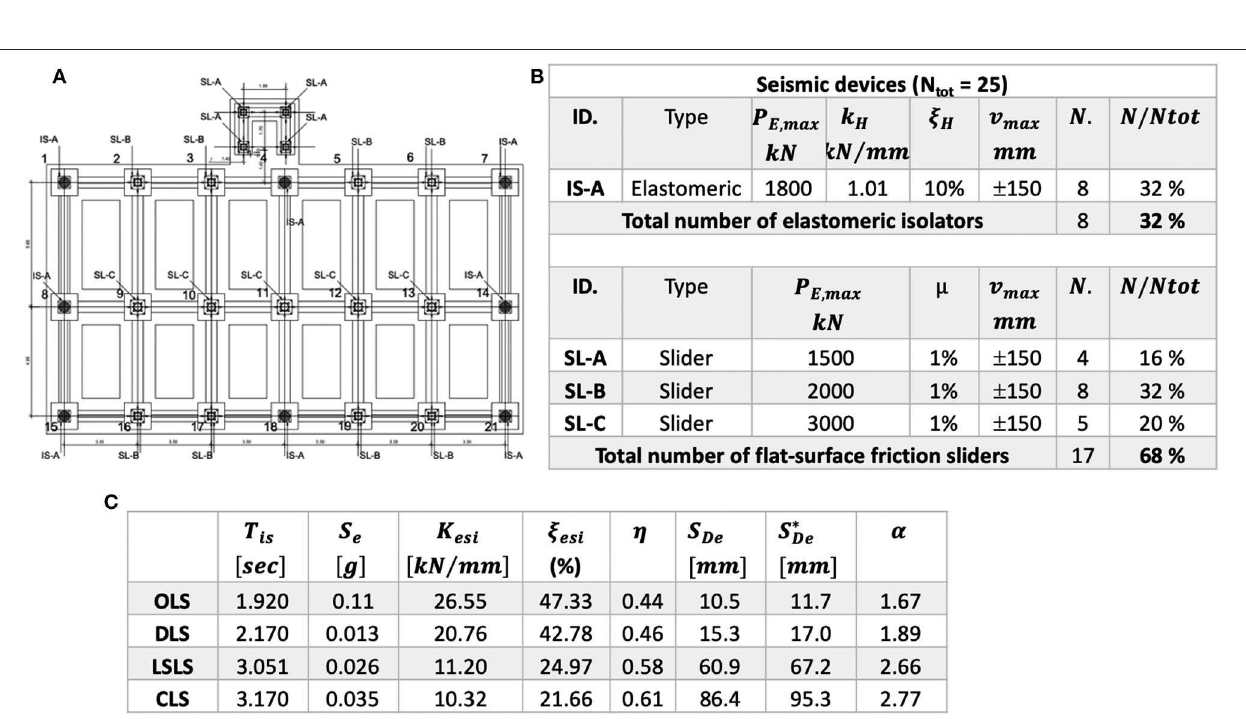
FIGURE 8 | Seismic isolation system: configuration and details. OLS, Operating Limit State; DLS, Damage Limit State; LSLS, Life-Safety Limit State; CLS, Collapse Limit State. (A) Plan of the isolation system, (B) devices details, and (C) properties of the isolation system.